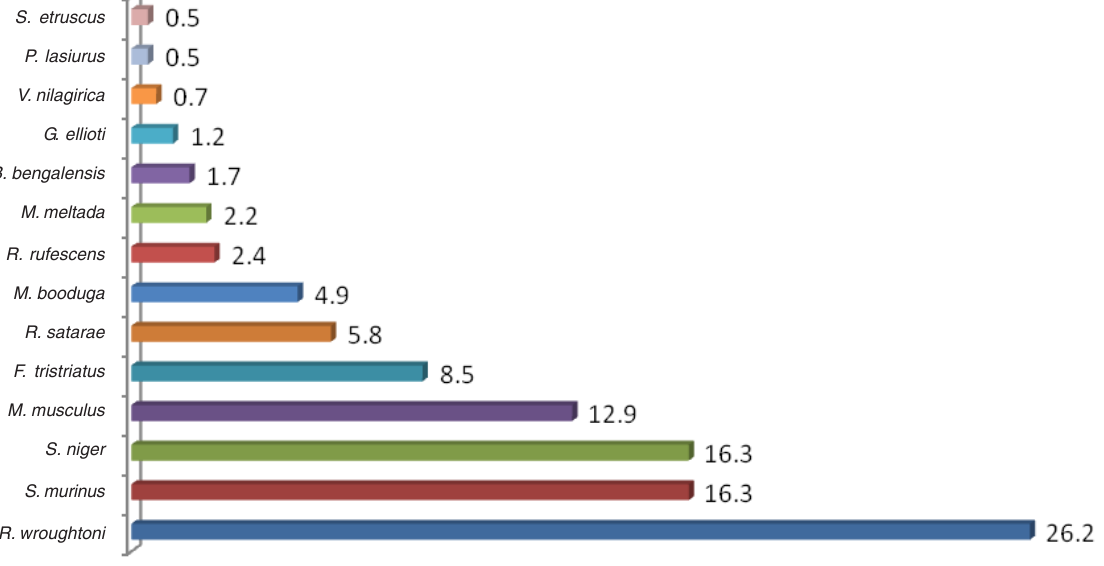
Figure 1. Proportions of individuals of small mammals trapped in